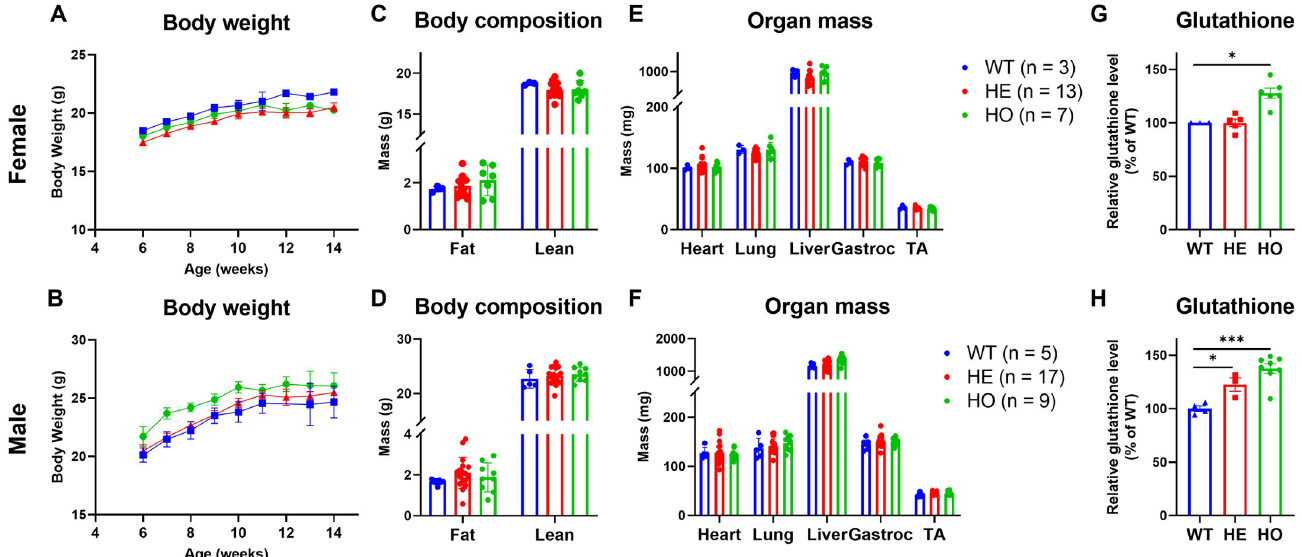
Fig 2. Normal development of the Chac1 E116A KI mice. A, B. Body weight curves from 6 weeks old to 14 weeks old, C, D. Body compositions in fat and lean mass, and E, F. Heart, lung, liver, gastrocnemius, and tibialis anterior (TA) muscle mass in WT, heterozygous (HE) and homozygous (HO) Chac1 E116A knock-in mice. G, H. Total glutathione measured in gastrocnemius muscles of WT, HE and HO KI mice. Data in top panels (A, C, E, G) were from females and the data in bottom panels (B, D, F, H) were from males. Results are shown as mean ± SEM with individual data plotted. Statistical significances were indicated as: * P < 0.05, *** P < 0.001.